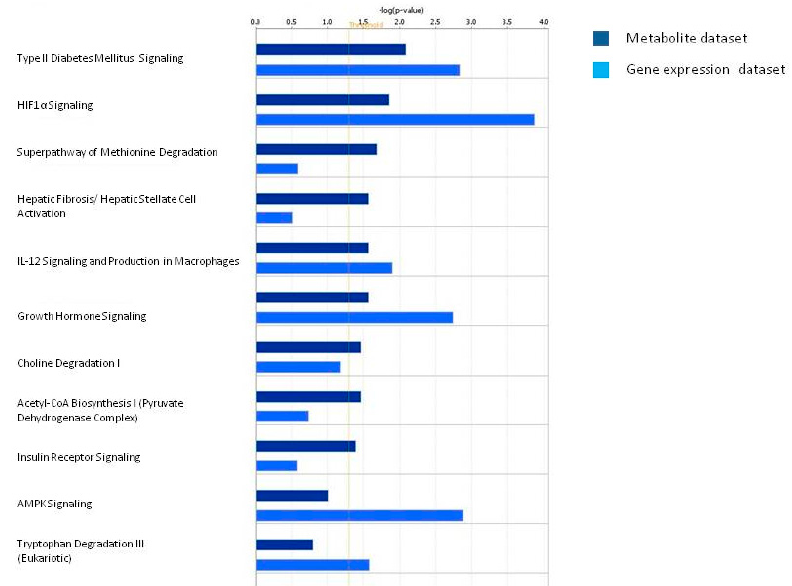
Figure 5. Pathway comparative analysis performed intersecting urinary metabolite dataset with the gene expression dataset from CD133+/CD24+ cancer renal stem cells of ccRCC patients.